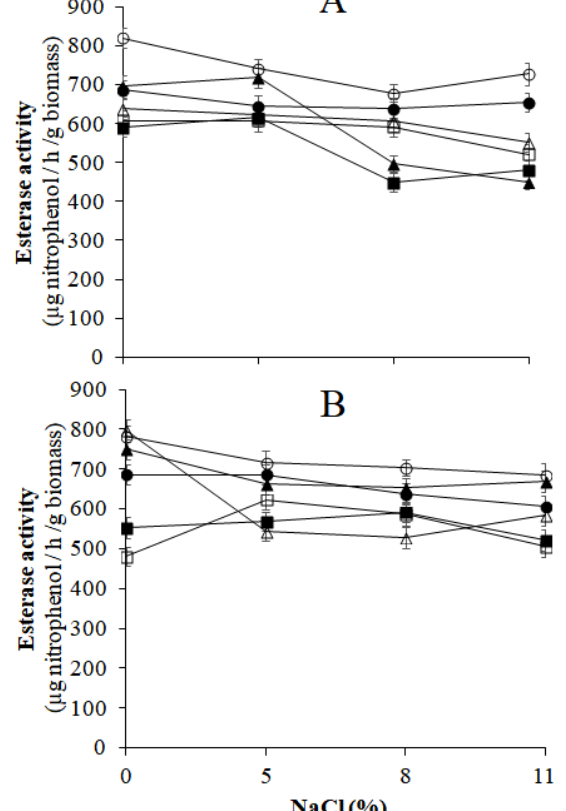
Figure 6. β‐ glucosidase activity of oleuropeinolytic yeast strains grown under aerobic ( A ) and slightly pressurized CO 2 ( B ) conditions, evaluated in the presence of NaCl. ( , S. cerevisiae 2046; 2054; , G. auringiensis 2080).